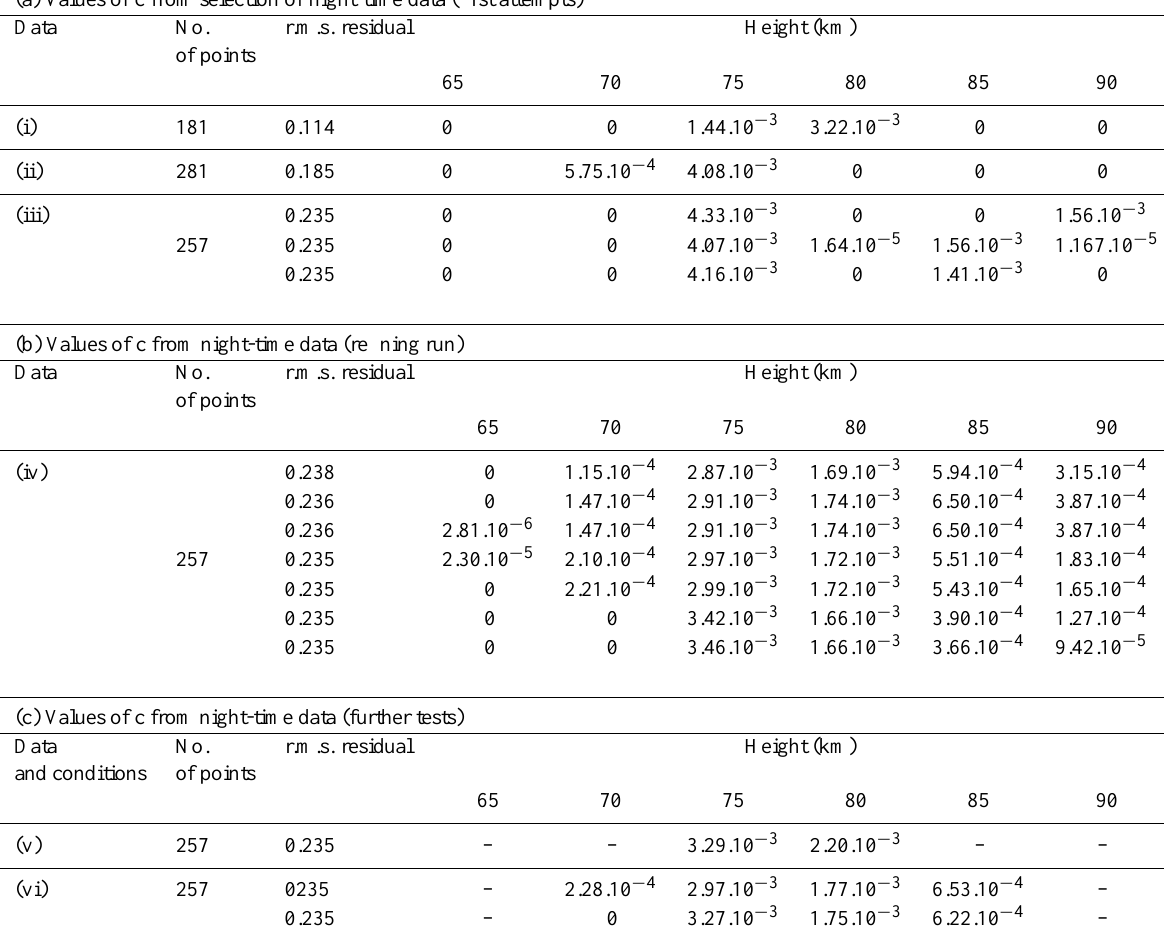
Table 2. Values of c derived from various night-time runs. (a) From three different selections of data: (i) One period in November; (ii) Periods from November and September; (iii) Three periods from November with a shorter one from September. Three progressive stages during run (iii) are shown. (b) Progressive stages of a refining run. The data set is the same as (iii), but the starting values are based on an average of the results in Table (a). (c) Further tests in which only a limited number of levels were permitted. In (v), only 75 and 80km were allowed to be non-zero. Four levels were allowed in (vi). In each case the data set is the same as in (iii) and (iv), and the starting guess is from the bottom line of Table